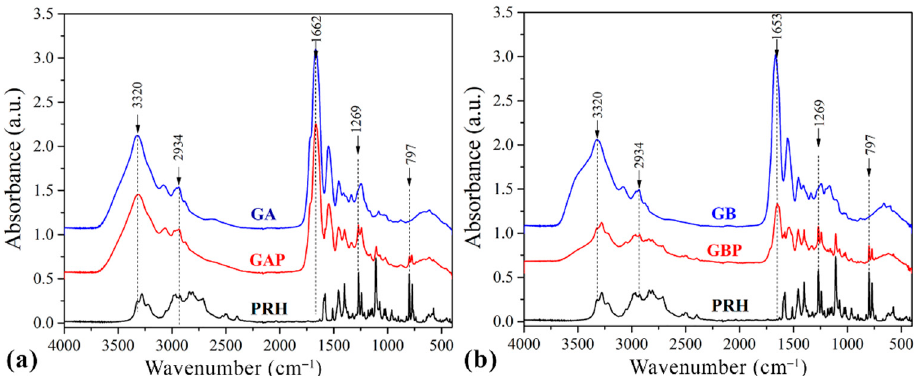
Figure 4. Fourier-Transfer infrared spectroscopy (FTIR) spectrums of ( a ) pure gelatin A film (GA), propranolol hydrochloride (PRH), and gelatin A film loaded with PRH (GAP); ( b ) pure gelatin B film (GB), propranolol hydrochloride (PRH), and gelatin B film loaded with PRH (GBP).